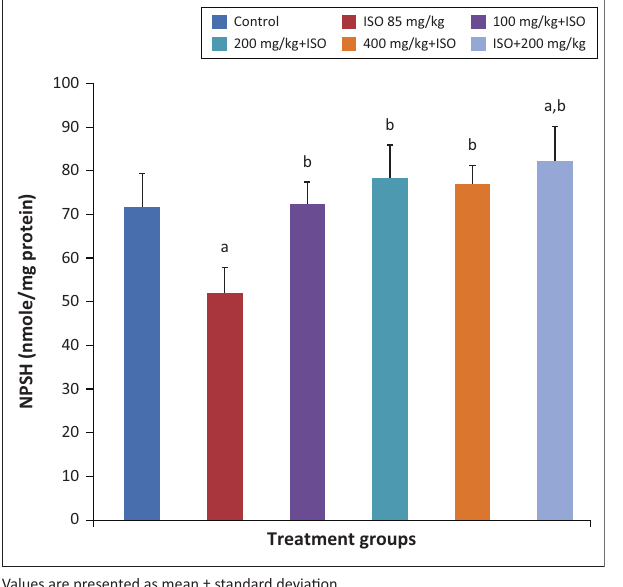
FIGURE 12: Effect of the ethanolic extract of Andrographis paniculata on myeloperoxidase in isoproterenol-induced myocardial infarction using rats as a model ( n = 5).